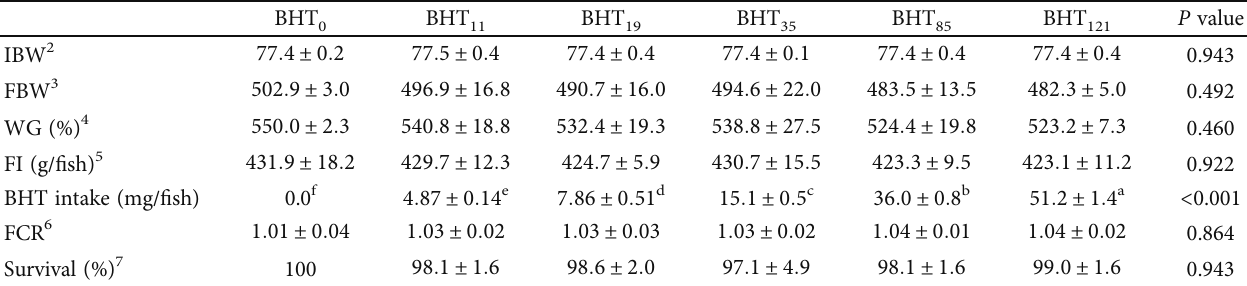
Table 2: Growth performance of olive fl ounder ( Paralichthys olivaceus ) fed experimental diets for 120 days 1 . BHT BHT BHT 0 11 19